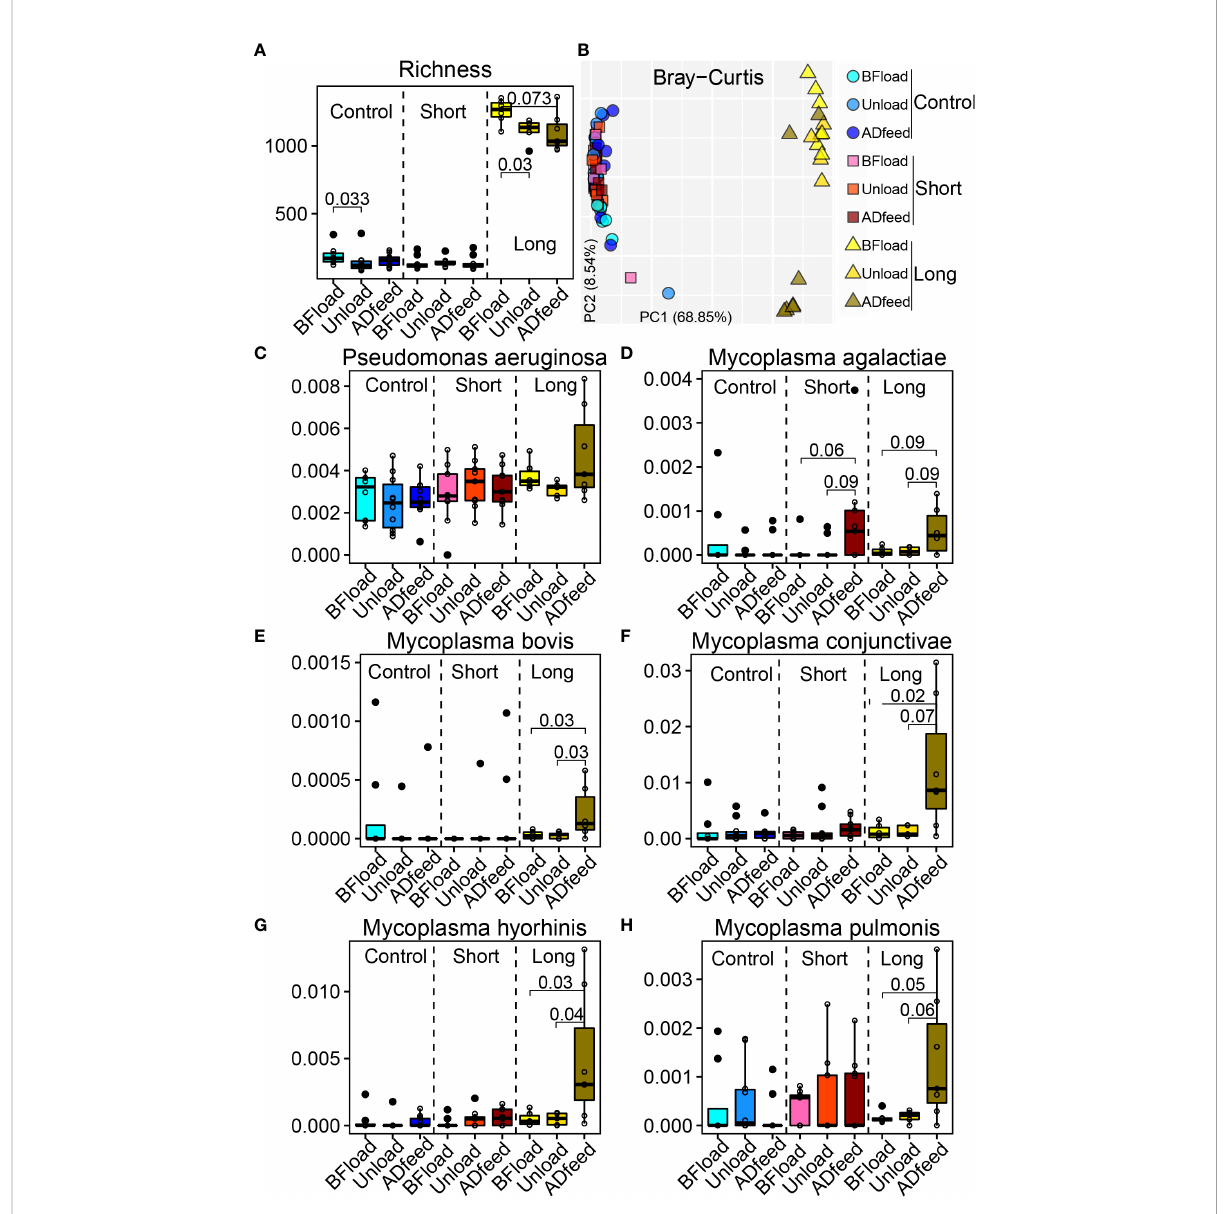
FIGURE 6 Long-distance transportation changes the bovine nasopharyngeal microbiota. (A) Richness. (B) Principal coordinate analysis plot based on the Bray – Curtis distance. (C – H) Main species associated with transportation. Control, non-transportation; Short, short-distance transportation; Long, long- distance transportation; BFload, time before loading to truck; Unload, unloading; ADfeed, 7 days after placement and adaptive